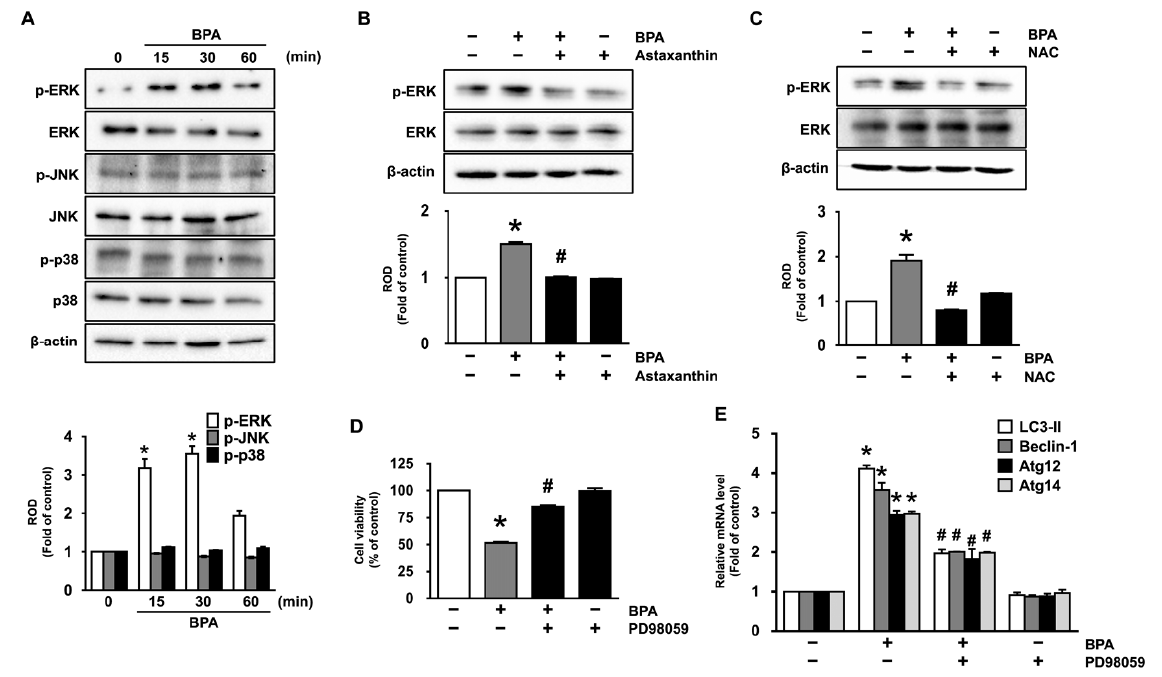
Figure 3. Astaxanthin inhibits ERK activation triggered by BPA. ( A ) Time responses of BPA (50 µ M) on the phosphorylation of MAPKs are shown. * p ≤ 0.05 versus control. n = 3. ROD, relative optical density. ( B ) The role of astaxanthin in the activation of ERK is shown. * p ≤ 0.001 vs. control, # p ≤ 0.001 versus BPA alone. n = 3. ( C ) Cells were pretreated with NAC (1 µ M) for 30 min prior exposure to BPA for 30 min. * p ≤ 0.001 vs. control. # p ≤ 0.001 vs. BPA alone. n = 3. ( D , E ) Cells were incubated with 1 µ M of ERK inhibitor (PD98059) for 30 min prior to BPA exposure for 24 h. The effect of PD98059 on the levels of cell viability ( D ) and autophagic genes ( E ) is shown. * p ≤ 0.001 versus control. # p ≤ 0.01 versus BPA alone. n = 3.